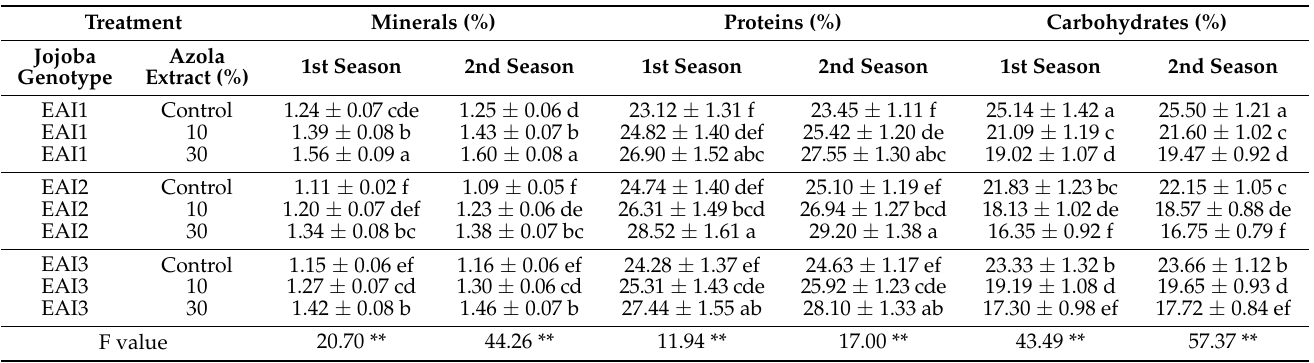
Table 4. In both seasons of the study, the mean values of minerals (%), protein (%), and carbohydrates (%) of jojoba shrubs as influenced by combined treatments of plant genotypes and foliar application of Azolla filiculoides Lam. plant extract.